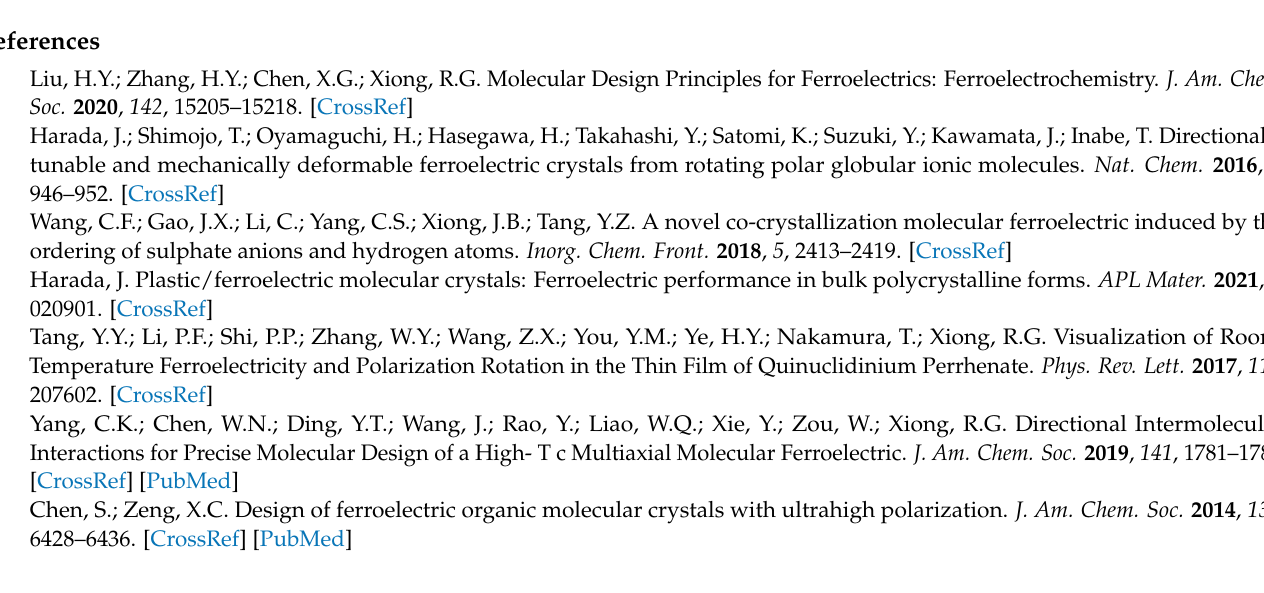
images of QP-60 and QP-80 thin films. Figure S3: AFM images of QP-60, QP-70, and QP-80 samples. Figure S4: Dielectric constant vs voltage plots of (a) QP-60, (b) QP-70, and (c)QP-80 capacitors at a frequency of 100 KHz. (d–f) the corresponding variation of dielectric constant (@ 50 V) with temperature. Figure S5: The XRD patterns of QP-60 sample measured at room temperature. Figure S6: The temperature-dependent reciprocal space maps (RSM) around the (10-1) plane of ITP and (110) plane of